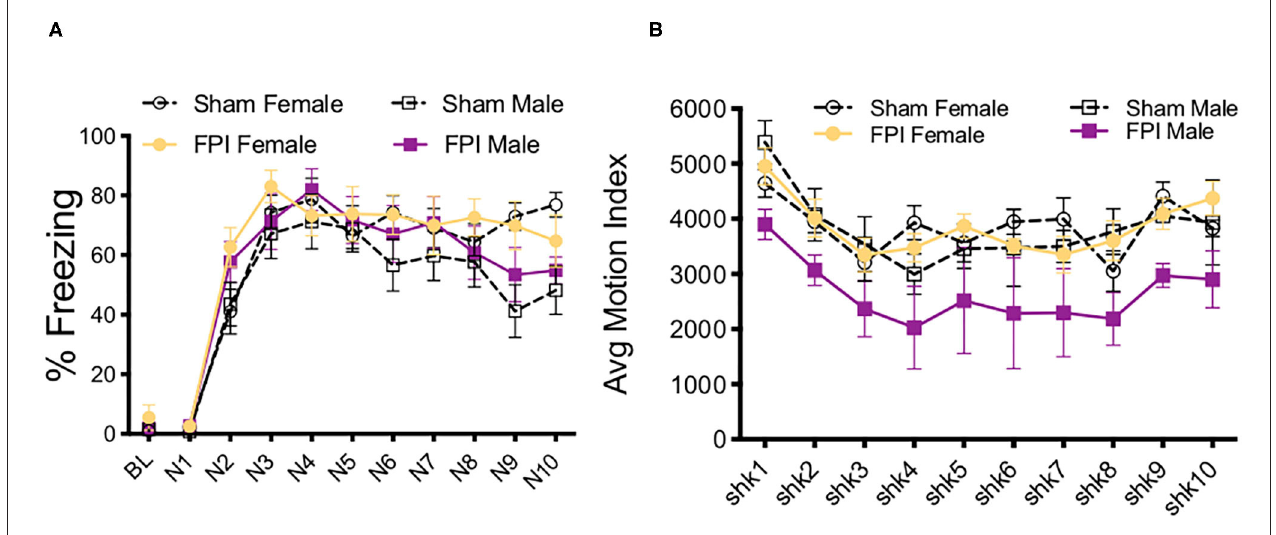
FIGURE 3 | White noise-shock fear conditioning as a traumatic stressor following FPI. (A) No differences in baseline freezing prior to white noise-shock fear conditioning. All groups increased freezing across conditioning trials, with no differences between sex or injury conditions. (B) Reactivity to shock across fear conditioning trials. Although FPI male rats tended to exhibit reduced shock reactivity across noise-shock conditioning trails, the average motion index during shock did not differ significantly across sex or injury group. Data are represented as mean ± SEM; n =